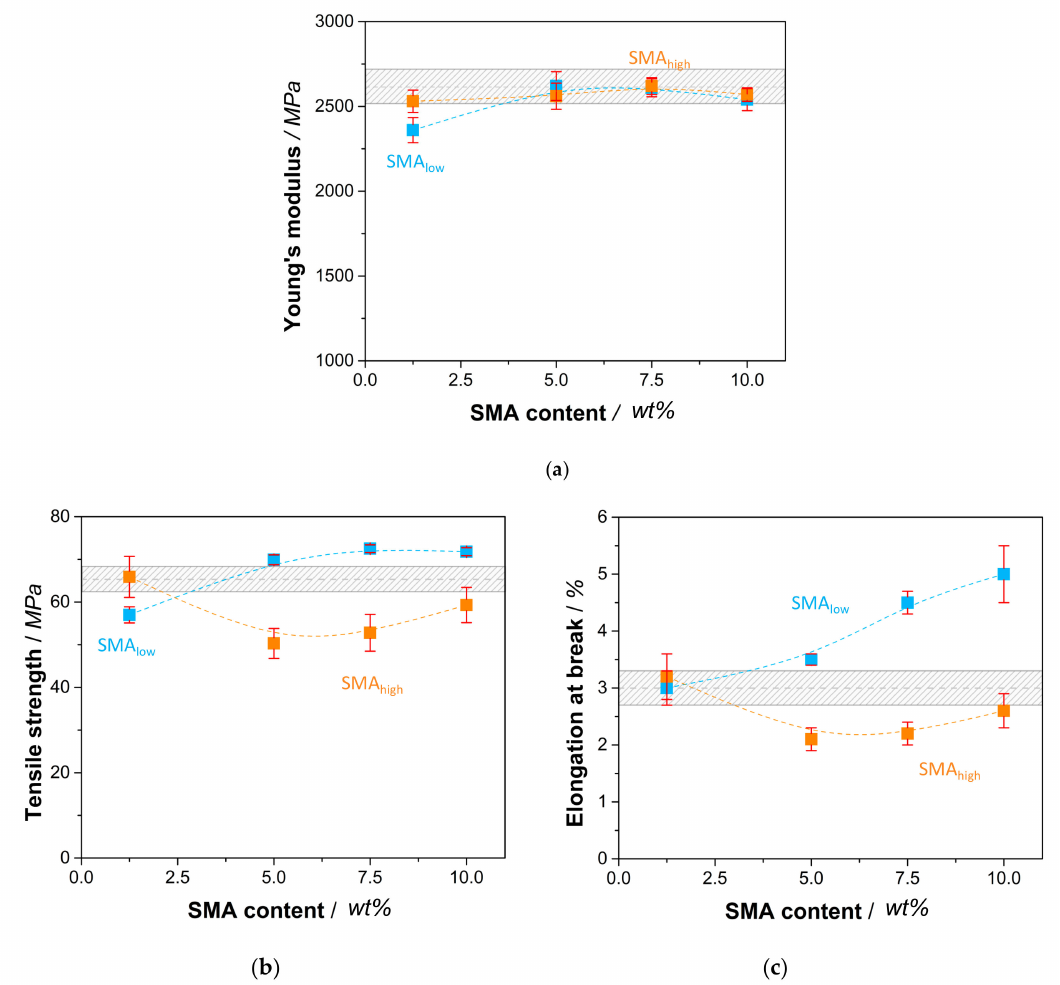
Figure 7. Tensile properties of SMA compatibilized PA66 / PPE blends with Young’s modulus ( a ), tensile strength ( b ), and elongation at break ( c ). All properties are plotted against the SMA content with SMA low (blue rectangular) and SMA high (orange rectangular). Gray bars represent the values of the PA66 / PPE binary blend without